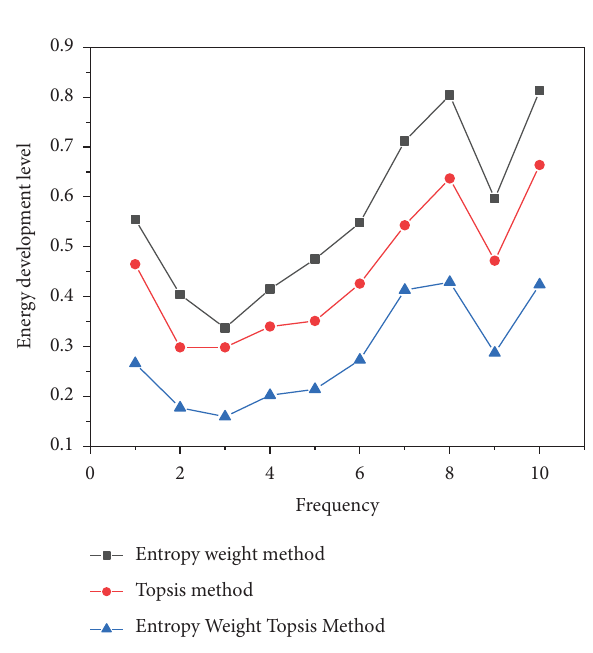
Figure 4: Comparison of energy development level results.